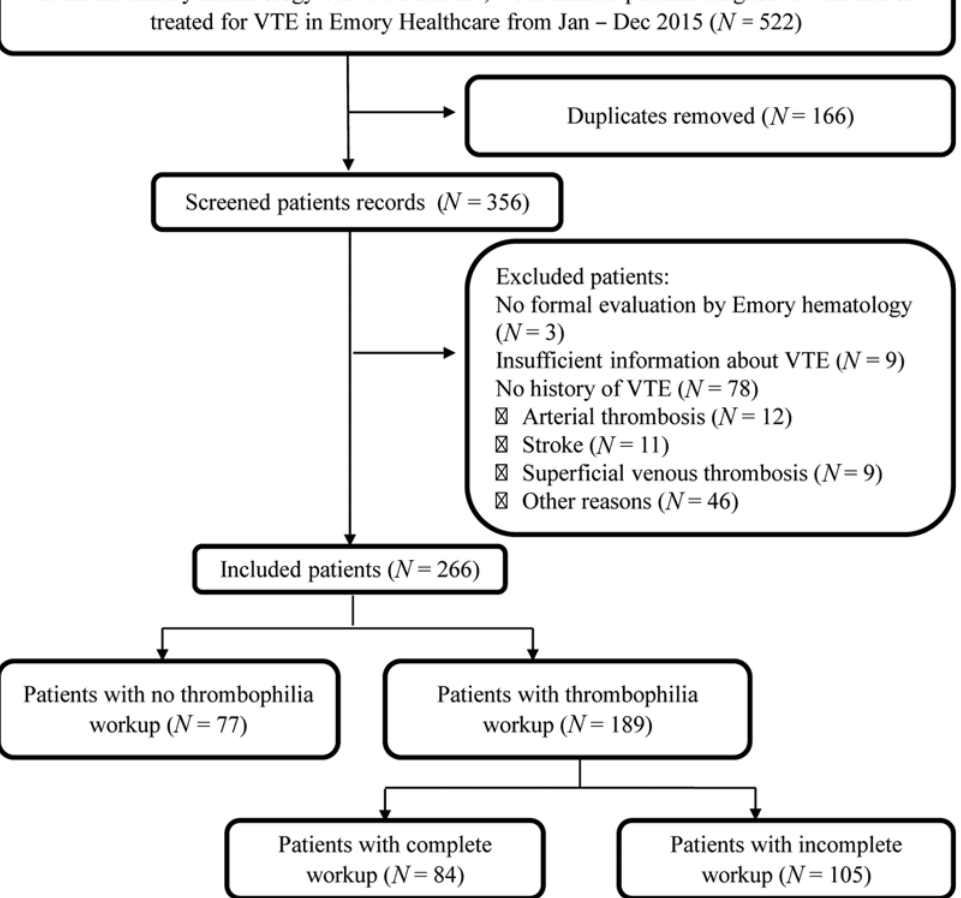
Fig. 1 Flowchart for patient identi fi